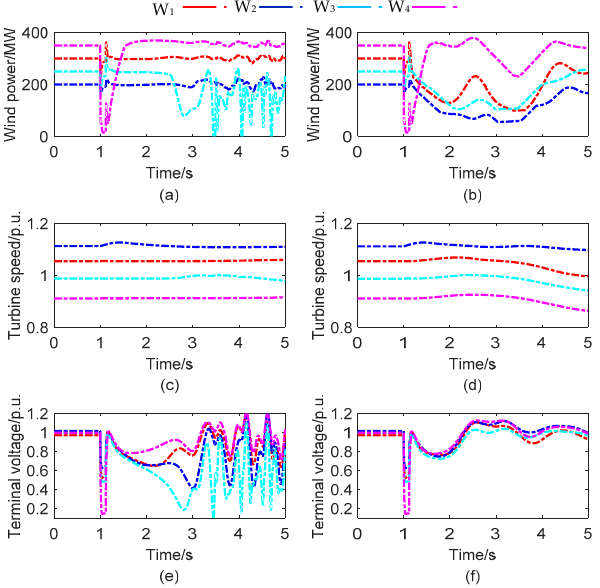
Figure 8. DFIG dynamics of ( a ) wind power, ( c ) turbine speed, ( e ) terminal voltage without PEC; DFIG dynamics of ( b ) wind power, ( d ) turbine speed, ( f ) terminal voltage with PEC.